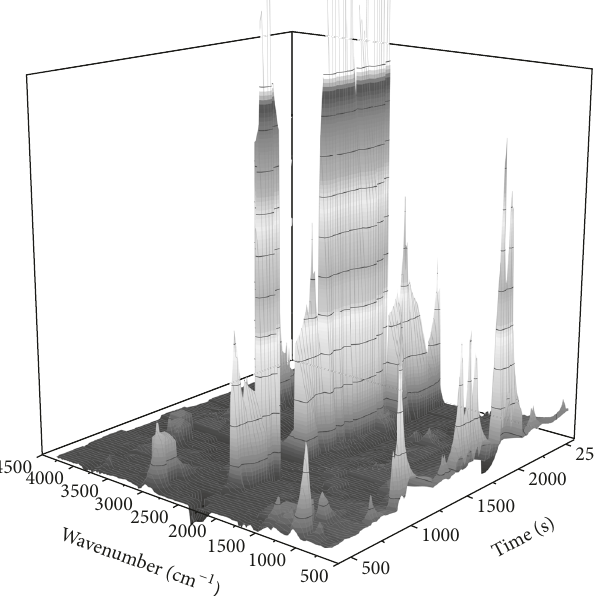
Figure 5: The stacked plot TG-FTIR spectra of the evolved gases for Cd(mef) 2 ⋅ 2H 2